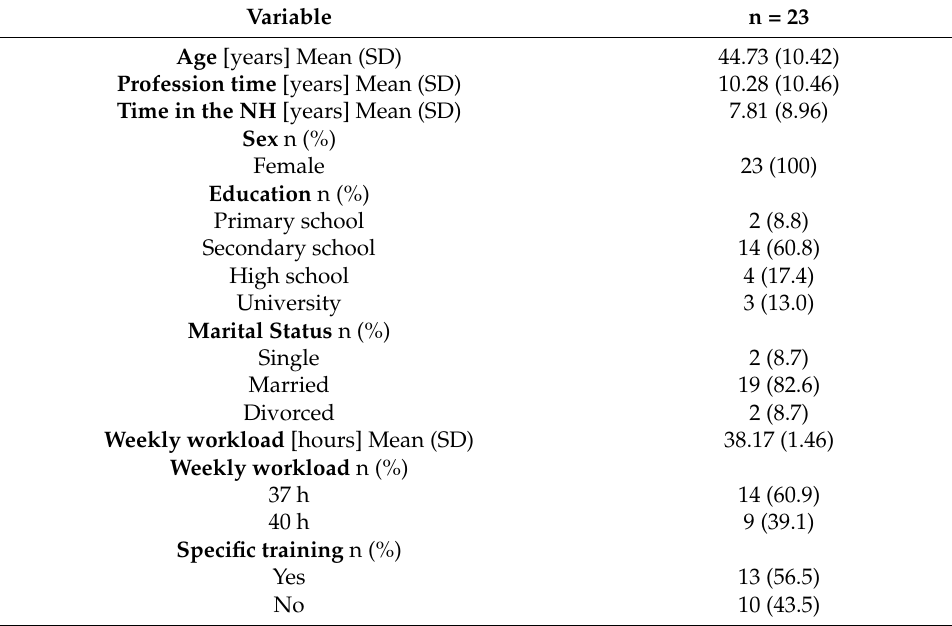
Table 2. Sociodemographic data (n =